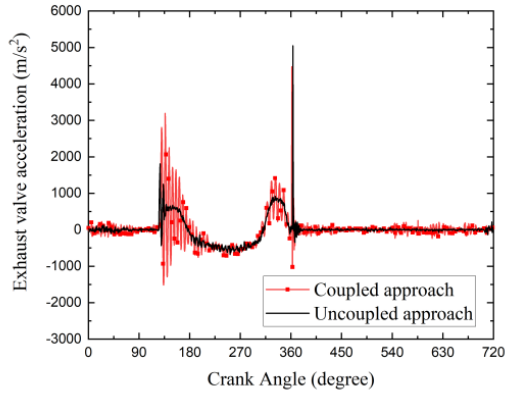
Figure 21. The exhaust valve acceleration comparison between the two approaches.